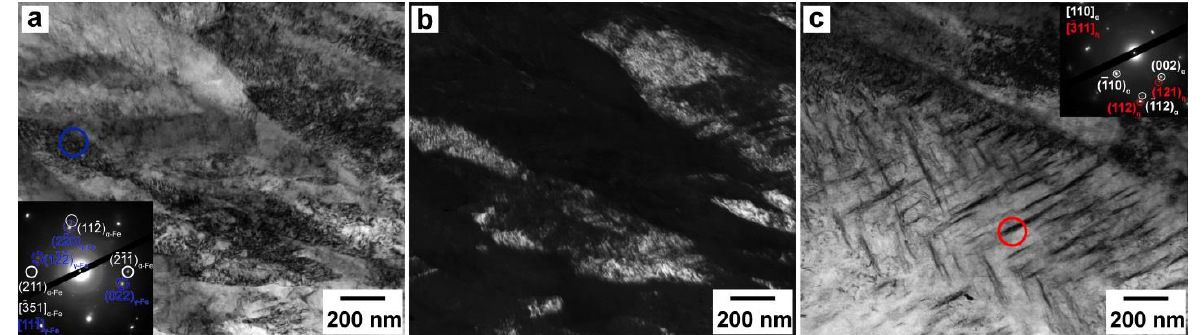
Figure 7. Typical microstructure of the steel after quenching at 160 °C: TEM micrograph of struc- ture ( a ); TEM micrograph of RA (dark field) ( b ); TEM micrograph of η - carbide within the marten- ( a ); TEM micrograph of RA (dark field) ( b ); TEM micrograph of η -carbide within the martensitic sitic lath ( c ). lath ( c